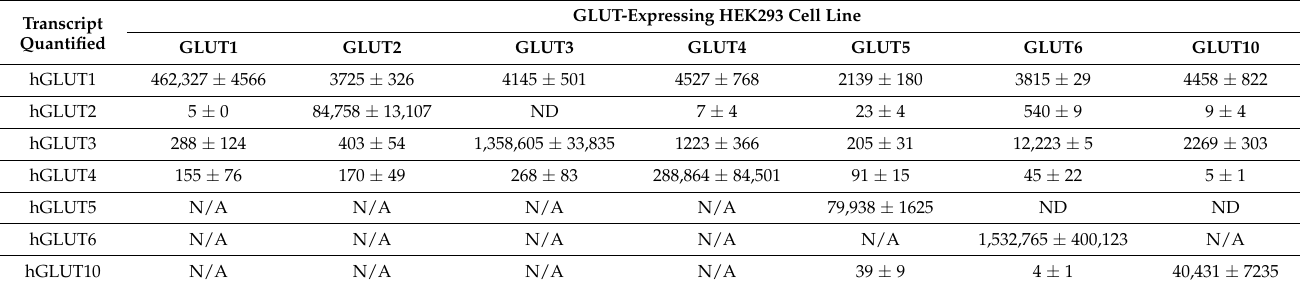
Table 2. Absolute mRNA copy numbers in the glucose transporter (GLUT)-HEK293 cell lines. GLUT-Expressing HEK293 Cell